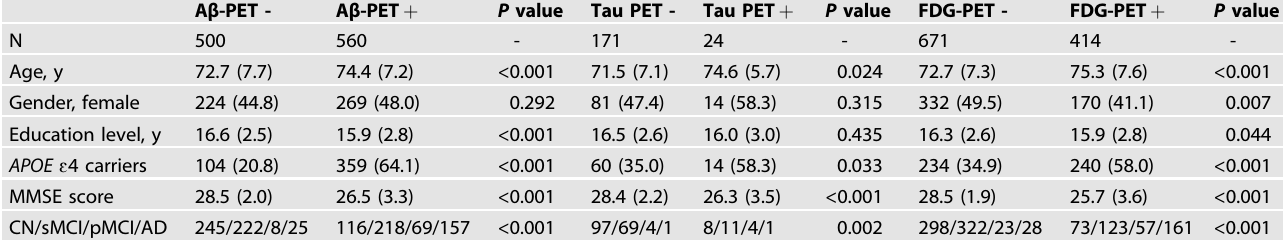
Table 1. Demographic features of the population in the present